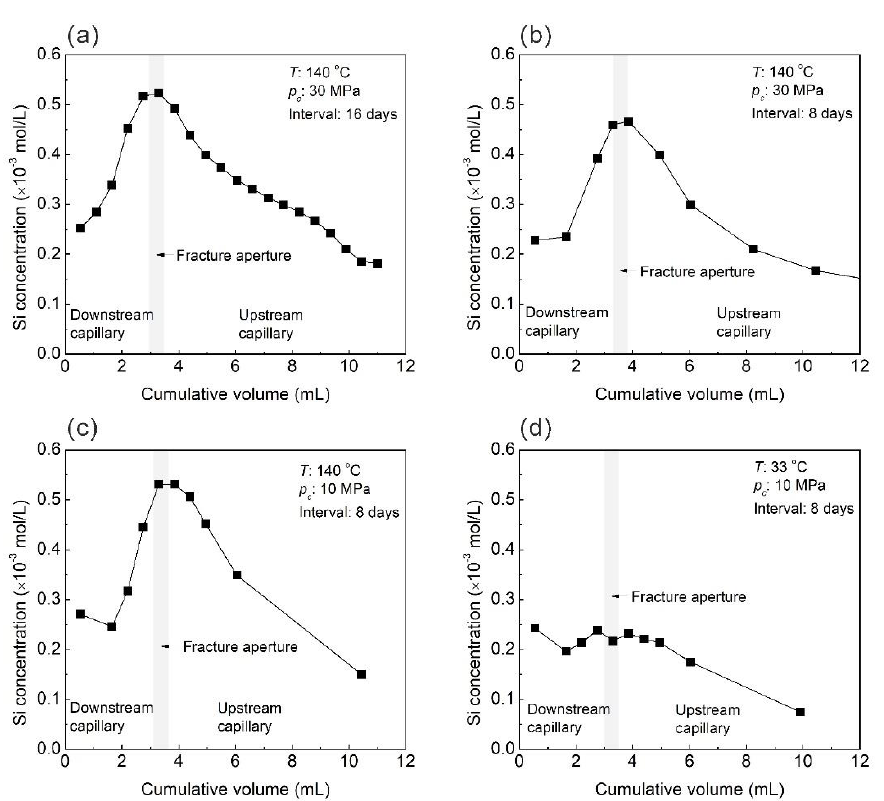
Figure 6. Si concentrations (as measured by a photometer) in the subsamples obtained from the relief valve as a function of cumulative volume. The gray stripe indicates the Si concentration in the fluid from the fracture void, and all the other dots are the Si concentrations in the fluids from the downstream and upstream capillaries, respectively. The fluids were sampled: ( a ) at 140 °C and a p c of 30 MPa after 16 days, ( b ) at 140 °C and a p c of 30 MPa after 8 days, ( c ) at 140 °C and a p c of 10 MPa after 8 days, and ( d ) at 33 °C at a p c of 10 MPa after 8 days of stagnant flow, respectively.